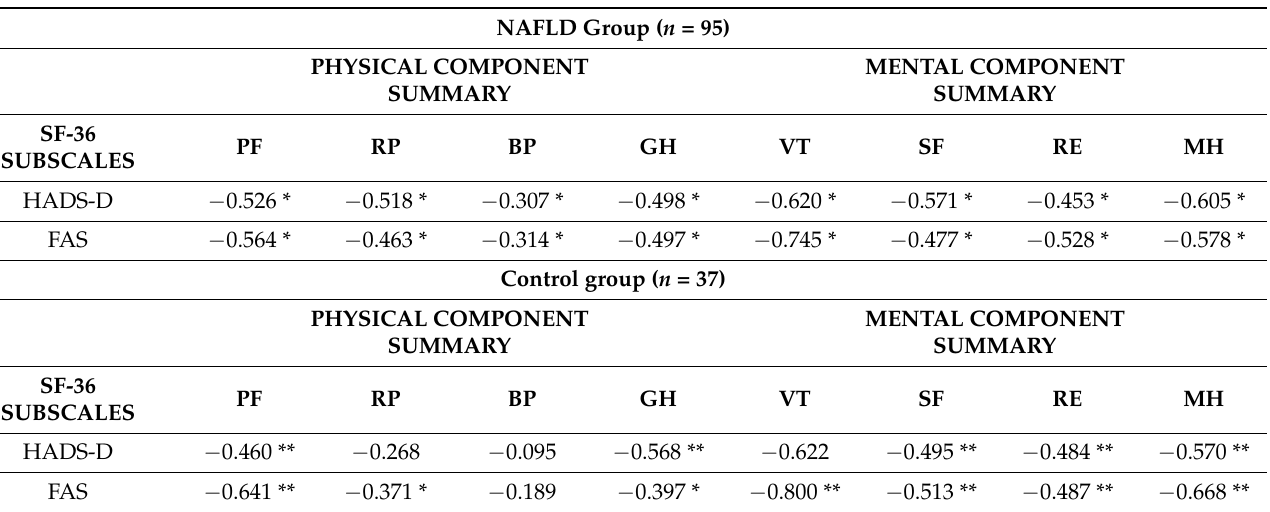
Table 2. Spearman’s rank correlation coefficients between HADS-D scores, FAS scores, and SF-36 subscales’ scores in patients with NAFLD and